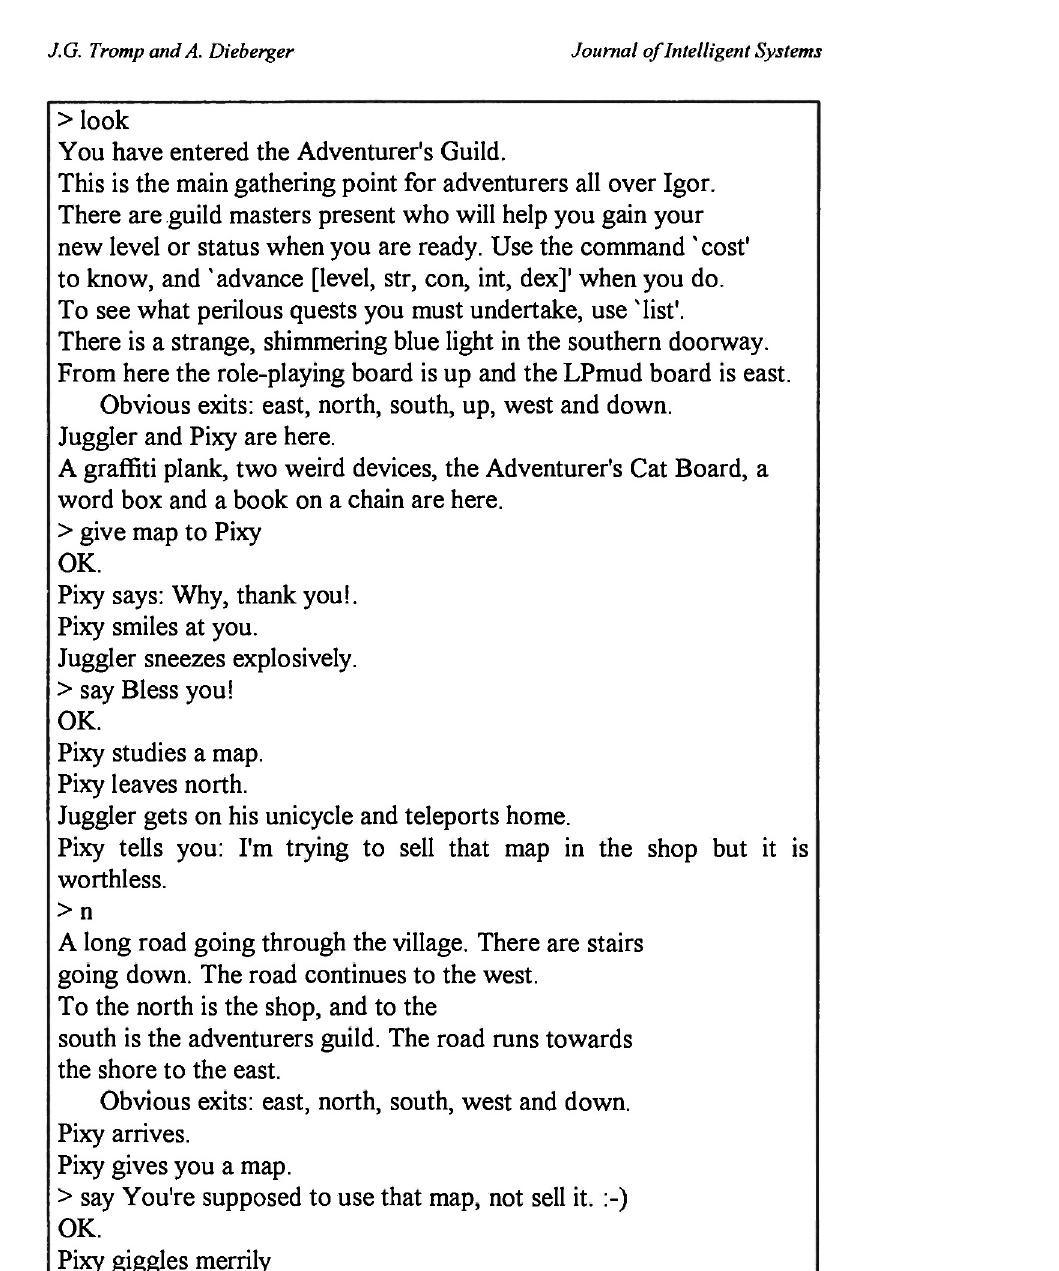
Fig. 1: Screenshot of some interactions on a MUD between participants, handling an object, teleportation, and walking from one room to another.